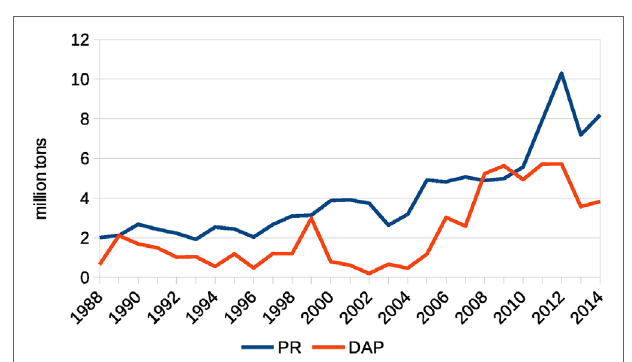
FigUre 6 | Indian import of phosphate rock (PR) and diammonium phosphate (DAP). Source: Comtrade.